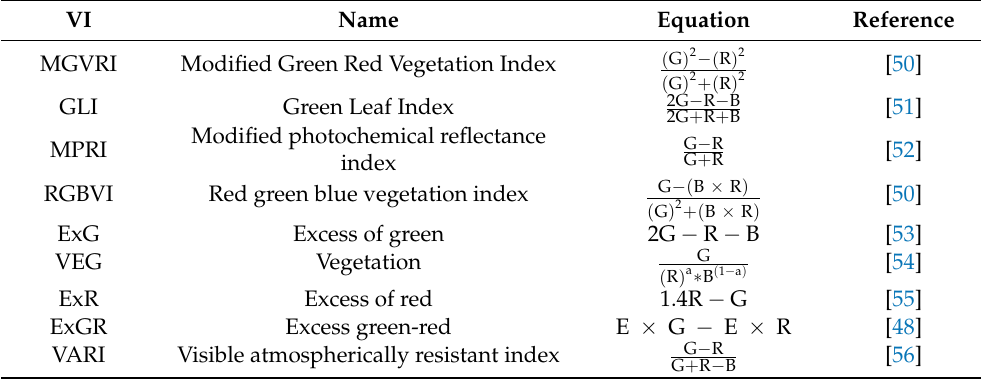
Table 1. RGB vegetation indices. VI Name